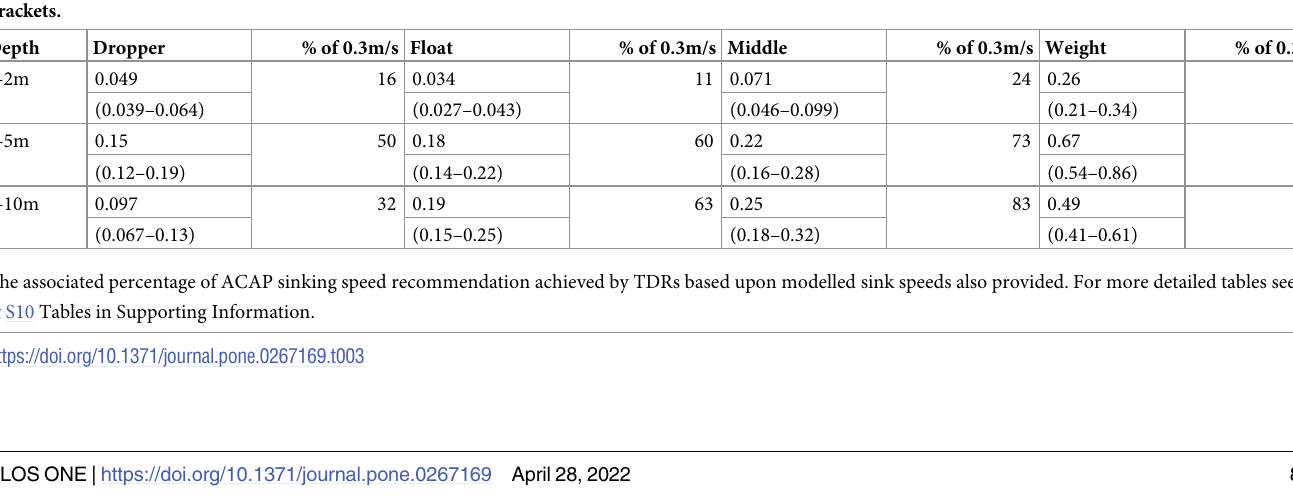
Values correspond to modelled estimates of average taken across all deployed TDR with the relevant longline location category. Bayesian 95% CRI are also displayed in brackets. For more detailed tables see S2, S4 and S6 Tables in Supporting Information.